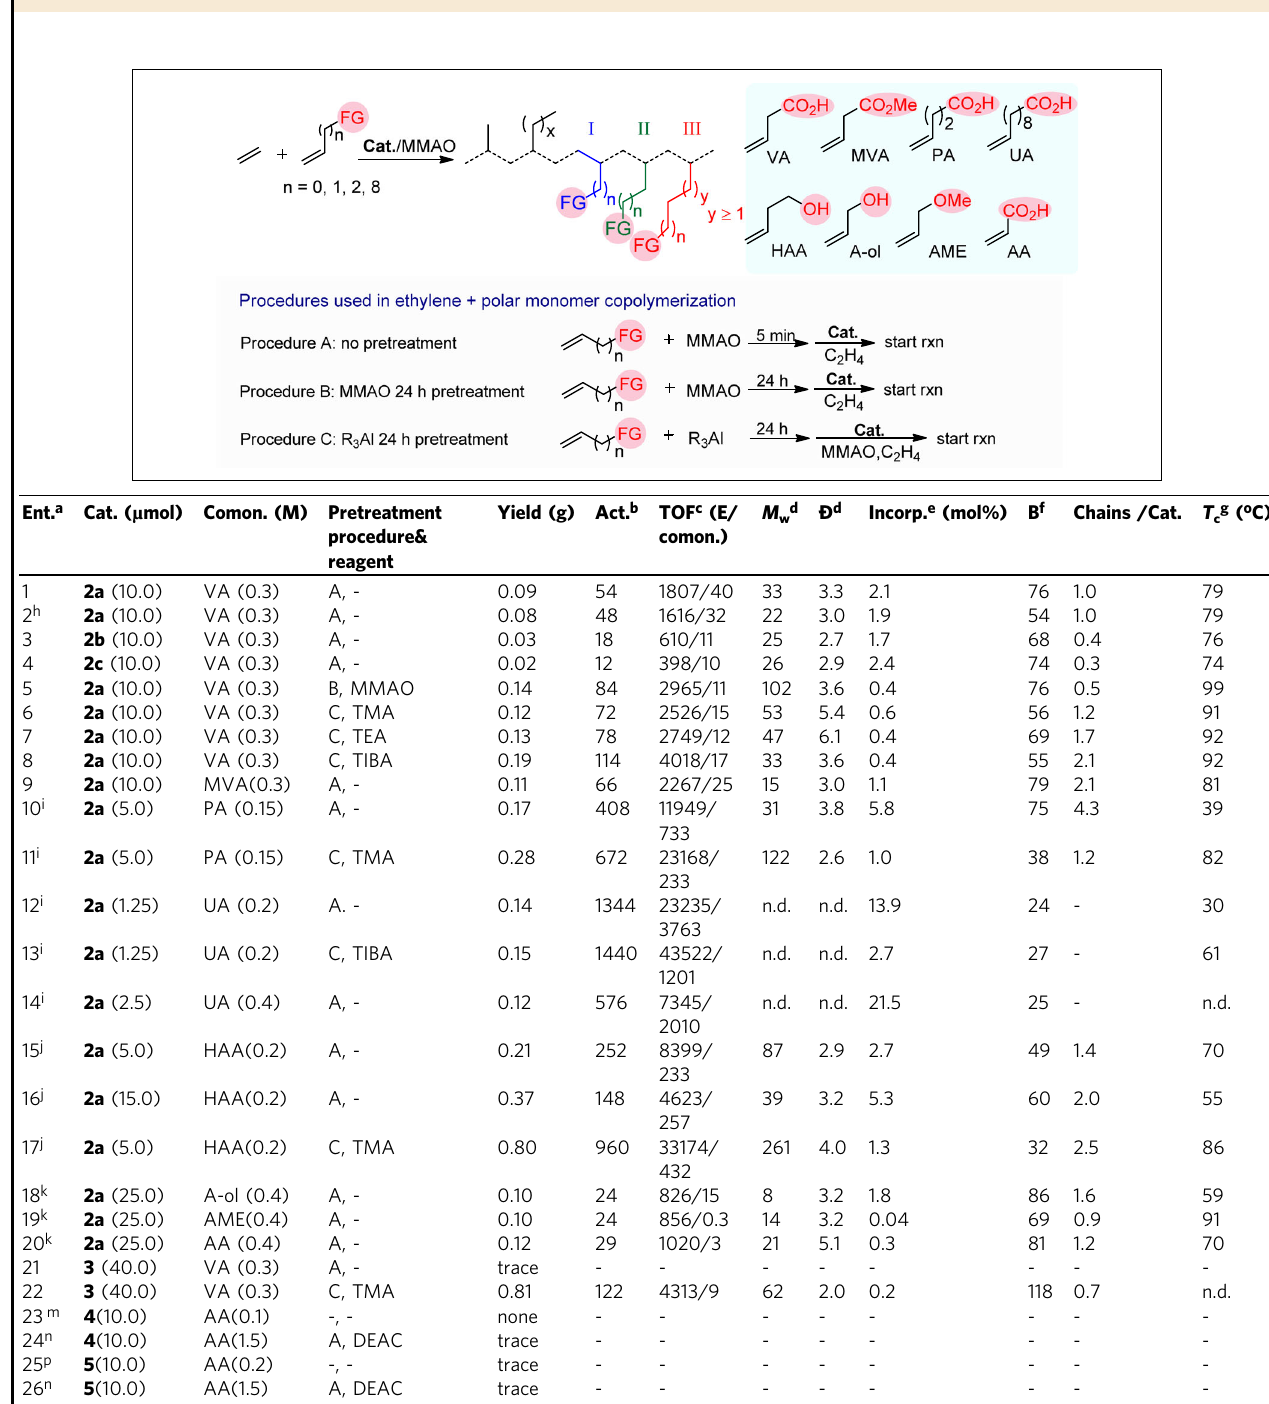
Table 2 Copolymerization of ethylene and various polar